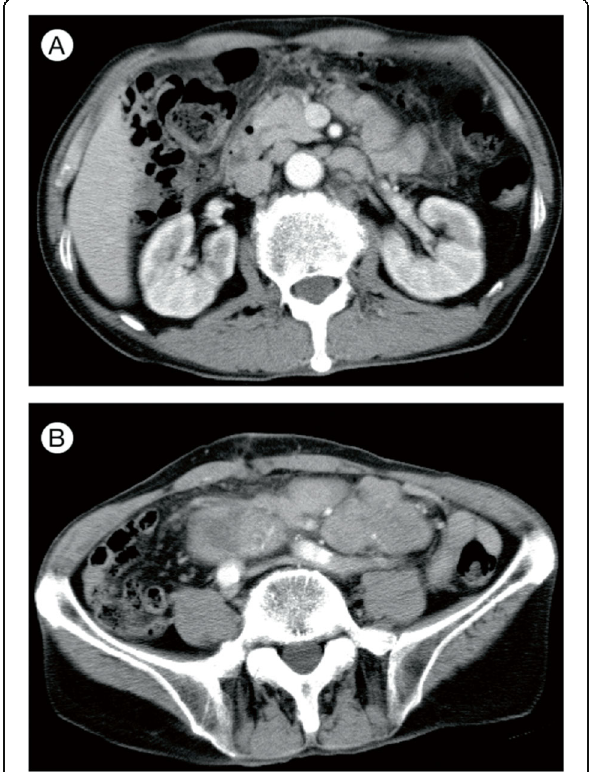
Fig. 1 Radiological findings of the abdomen: Abdominal computed tomography scan revealed multiple lymph nodes were swollen in retroperitoneum ( a ) and mesentery ( b